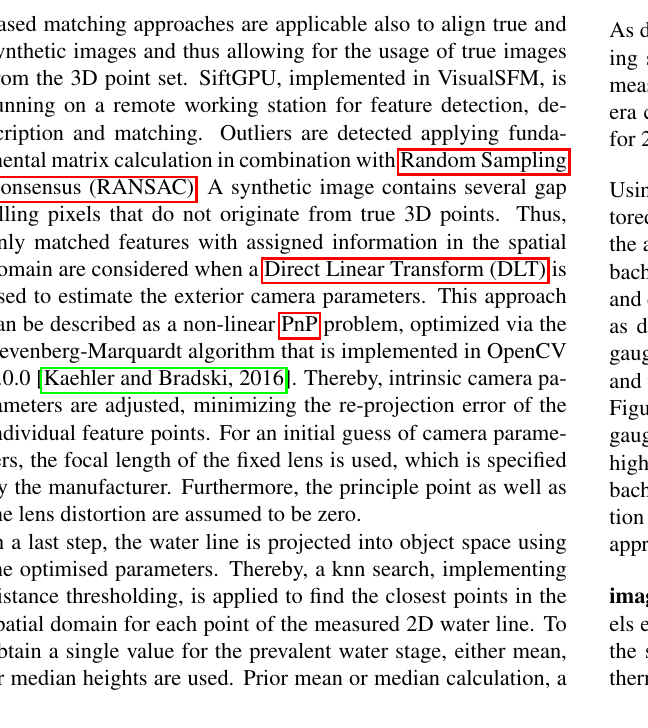
Figure 4. Gauging of the Weißeritz. Average image